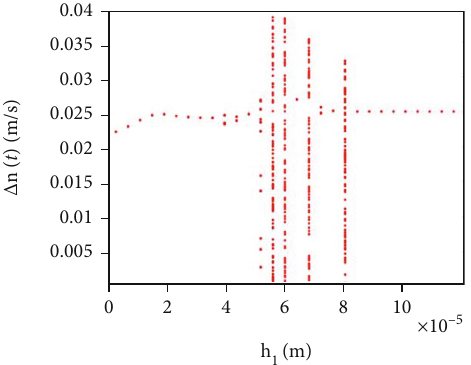
Figure 14: Bifurcation diagrams with changes in the uniform wear when the misalignment in the x direction is 3 : 4 × 10 − 4 m.